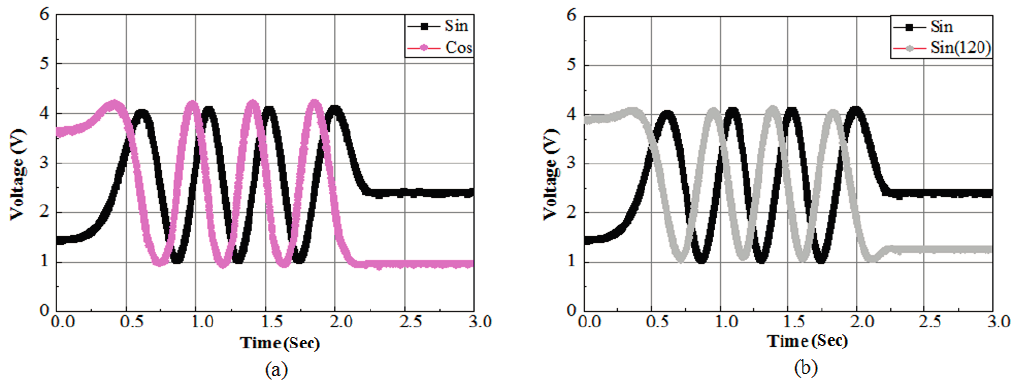
Figure 8. ( a ) Two phase (90° phase shift) and ( b ) proposed method (120° phase shift) sensor